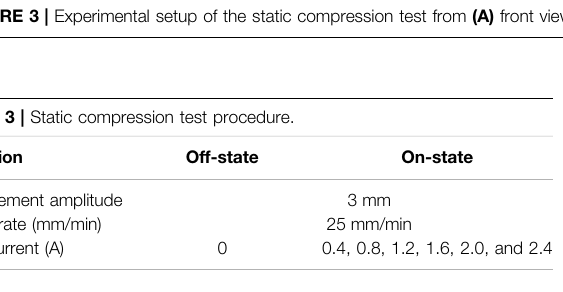
Frontiers in Materials |